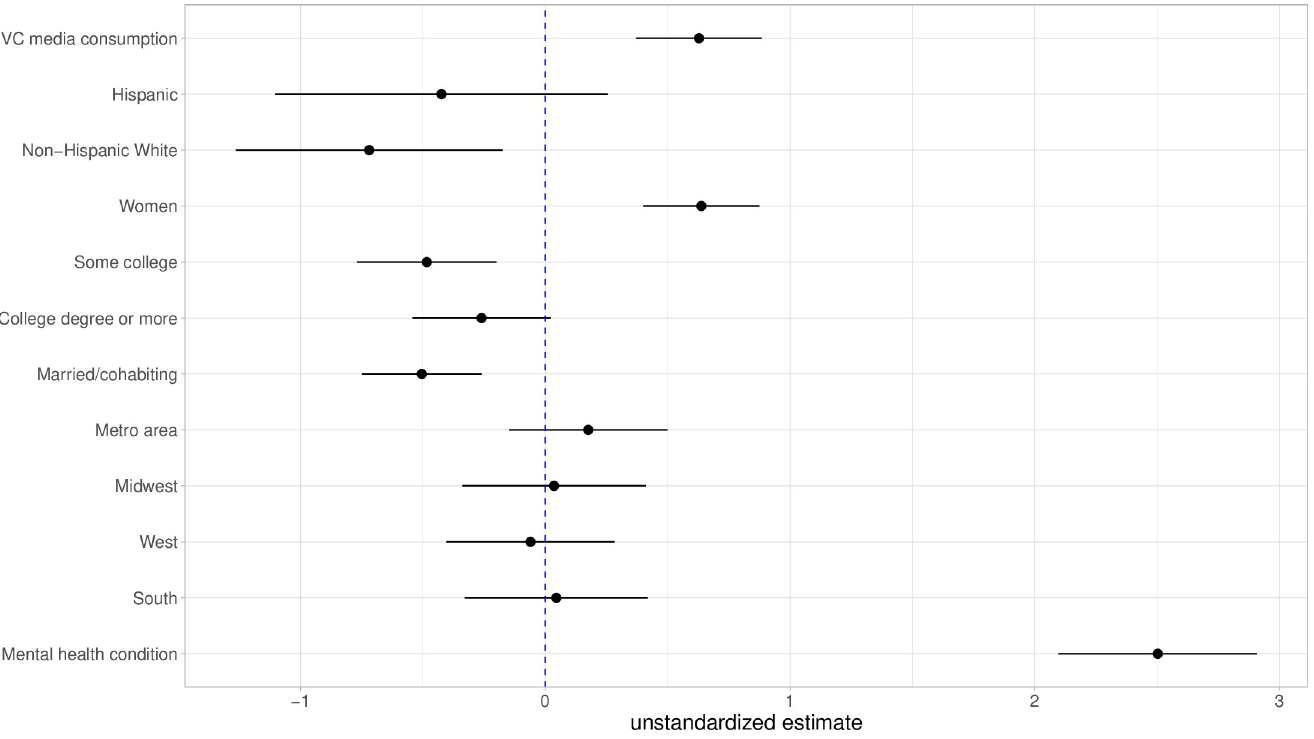
Fig 1. Estimates of coefficients from regressing psychological distress on media consumption and all other covariates. Estimates are unstandardized with 95 percent confidence intervals. See text for the referent categories. The regression model incorporated the sample weights.